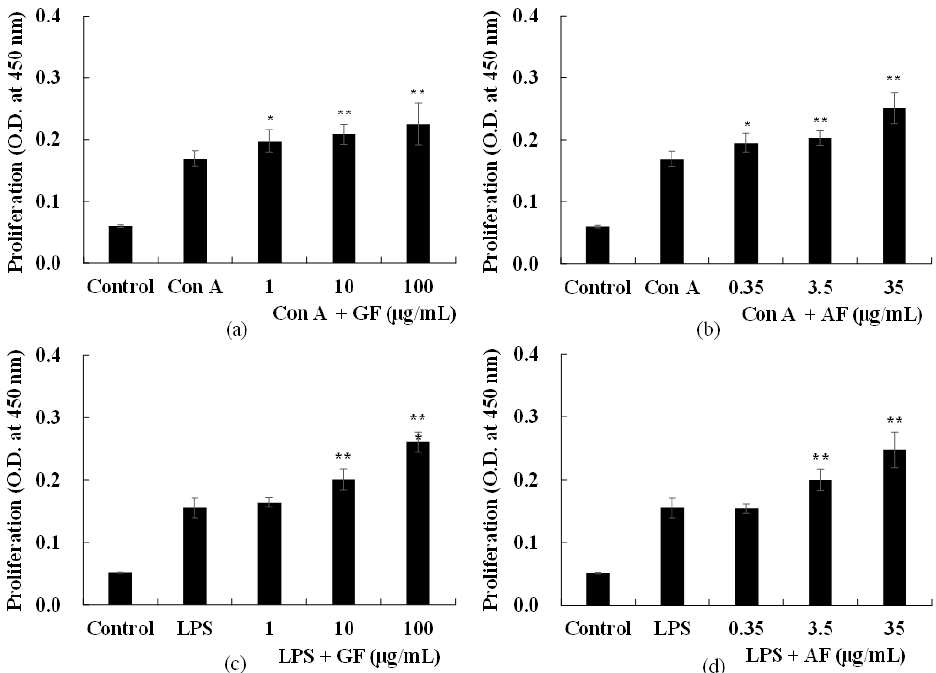
Figure 2. Splenocyte proliferation induced by Con A and LPS of Ginofos extract (GF), Arginyl-fructose (AF) ex-vivo. Mouse Splenocytes were stimulated with Con A (15 µ g/mL), LPS (500 µ g/mL) in the presence of various concentration of GF, AF for 48 h. Con A group (GF: ( a ), AF: ( b ), LPS group (GF: ( c ), AF: ( d ) was cultured with Con A alone. The splenocyte proliferation was assessed by MTT. The results are expressed as the mean ± S.D of different experiments and all experiments were done in triplicate. Statistical significances from Con A group were determined by Student’s t -test (* p < 0.05, ** p < 0.01).